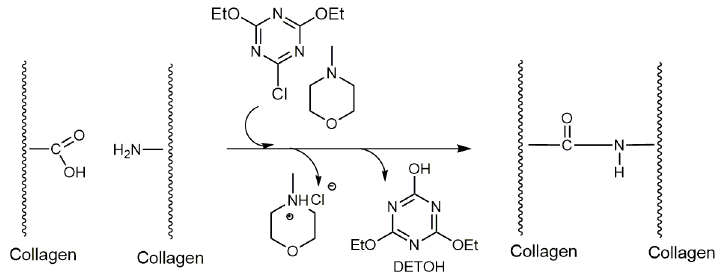
Table 3. Shrinkage temperature of collagen cross-linking by different CDET/ tert -Amine systems. Entry Coupling Agent (a) Ts (°C)